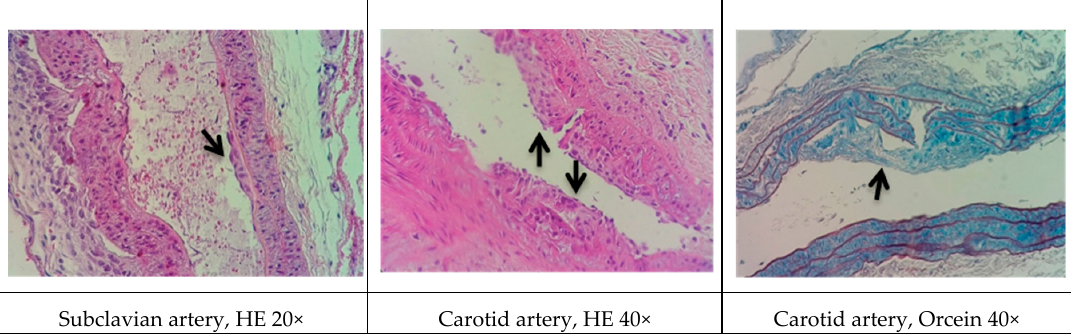
Figure 1. Representative cross-sections of the liver, left ventricle, kidney, and subclavian and carotid arteries in the NEAD group. Black arrows indicate cardiac fibrosis, lipid macrovesicles in the liver, and lipid striae in the arteries. HE, hematoxylin-eosin staining; NEAD, normotensive and non-ovariectomized rats that received the atherogenic diet, methimazole, and cholecalciferol.